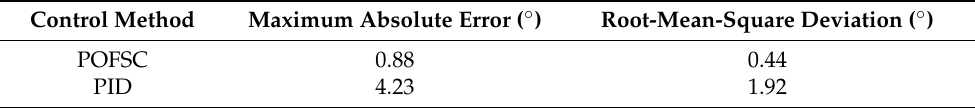
Table 11. Error comparison using the POFSC and PID for the elbow joint (75°).